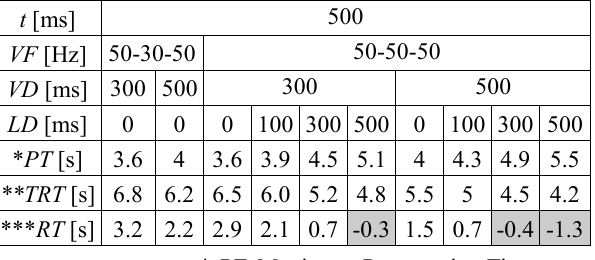
* PT : Maximum Presentation Time of each Braille cell ( 6t + 2VD + 3LD ) ** TRT : Total Recognition Time ( RT + PT ) *** RT : Recognition Time